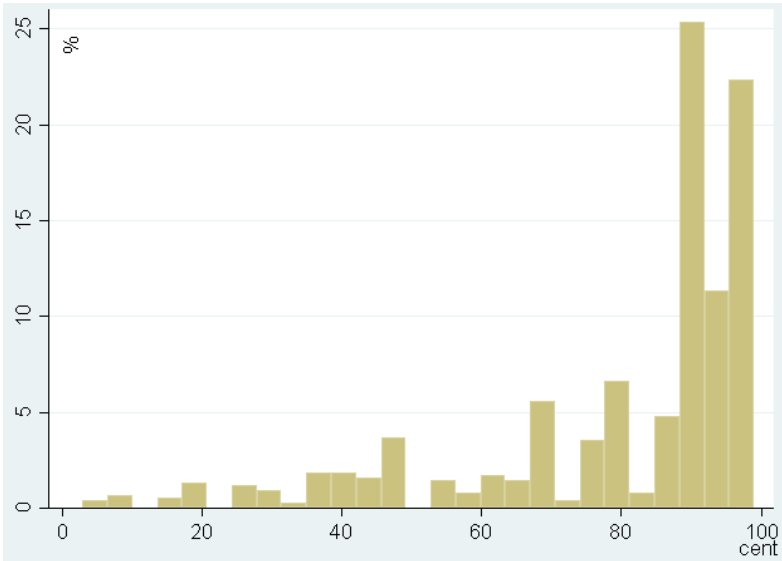
Figure 4. Distribution of sell offers not ending in whole or half dollar amounts.